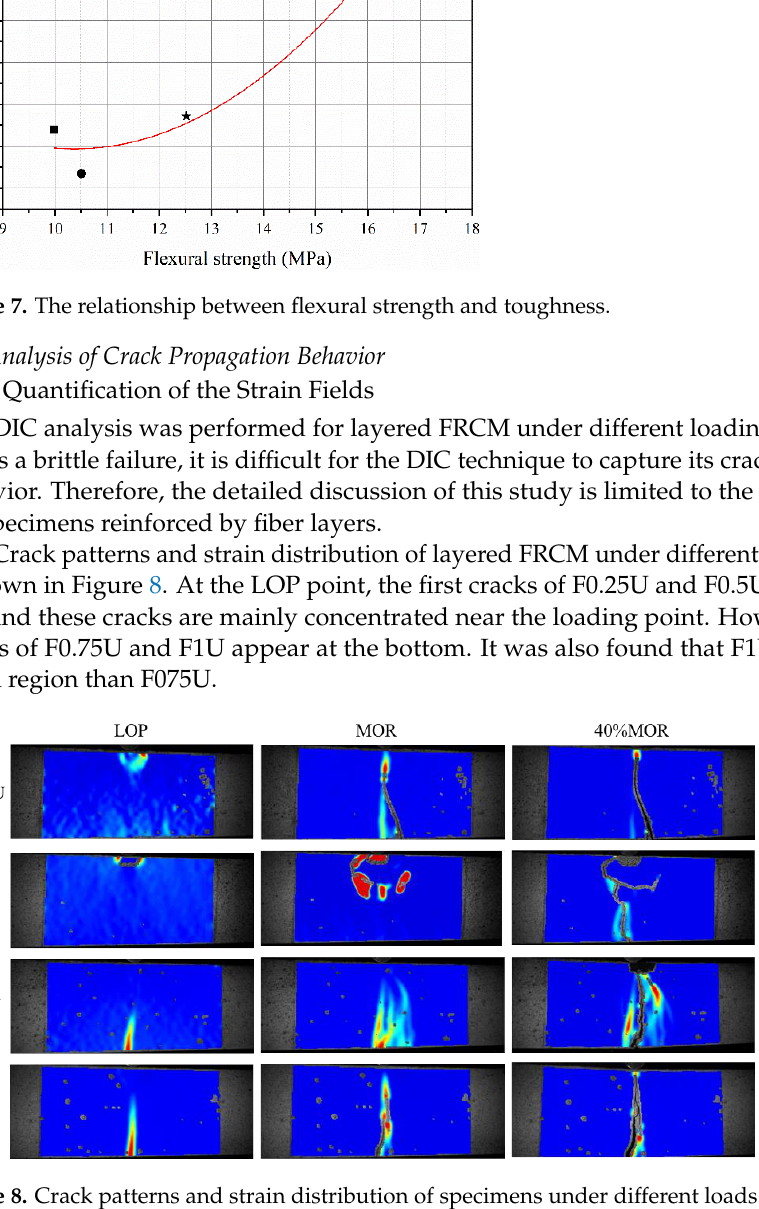
Figure 6. Deflection capacity ( a ) and toughness ( b ) of specimens.